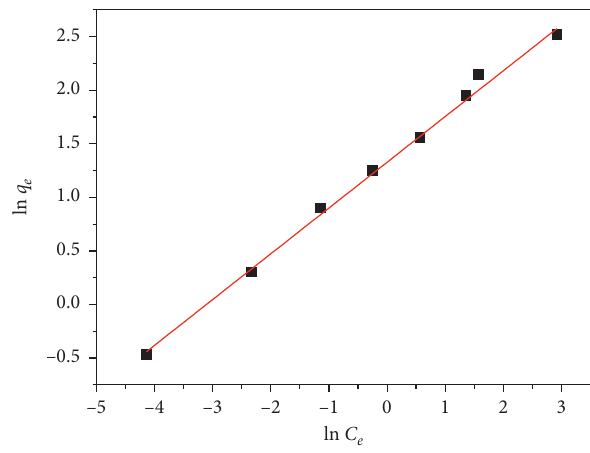
Figure 7: Freundlich model for brilliant green dye onto